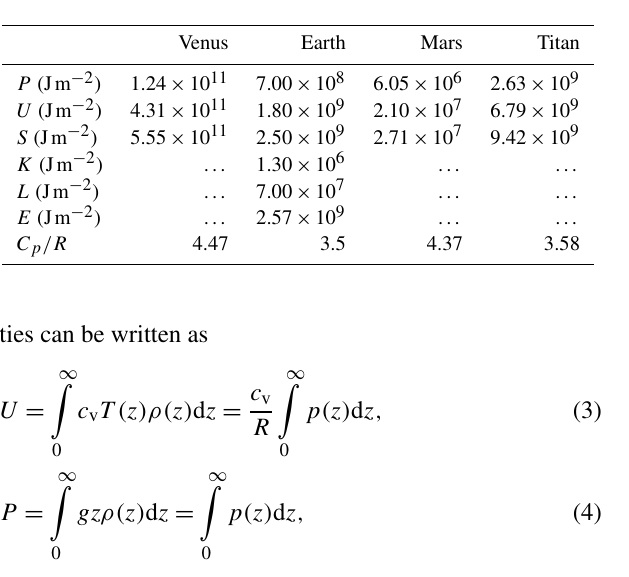
Table 1. Forms of energy in planetary